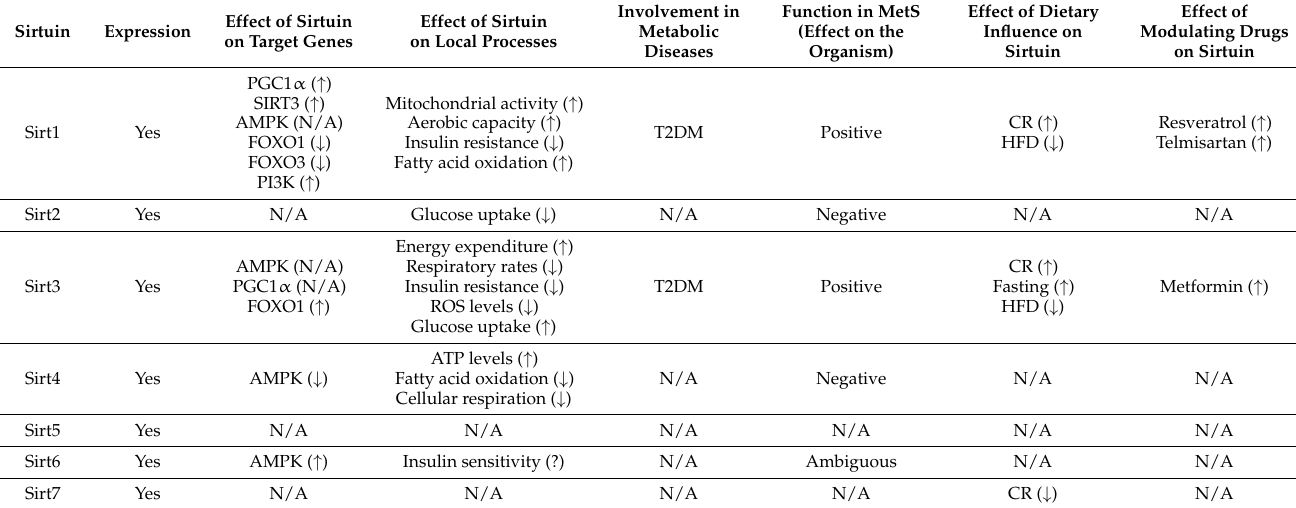
Table 5. Overview of the role of Sirtuins in the skeletal